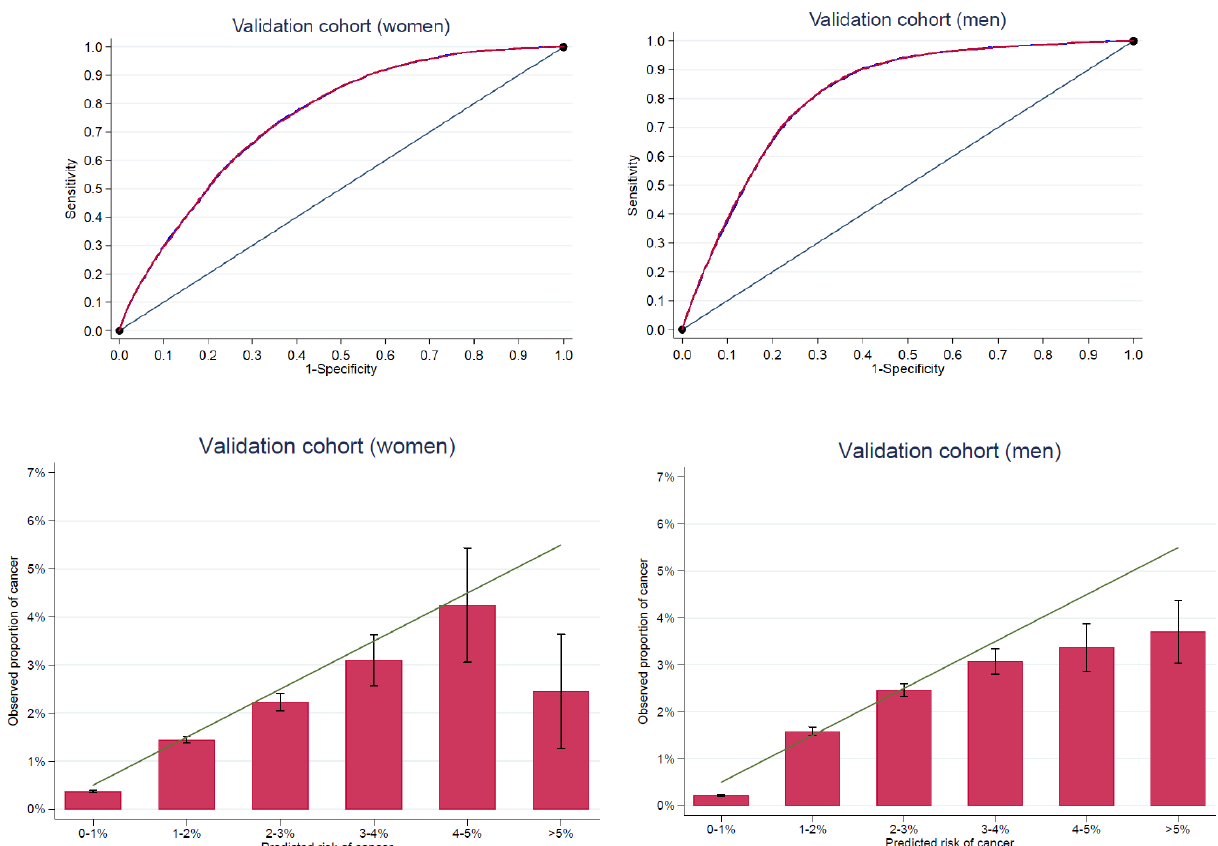
Figure 2. ROC curves in the validation cohort with cancer as the outcome for the CRAM model. Model A (blue) and Model B (red) are almost indistinguishable ( upper figures ). Predicted versus observed cancer cases with 95% confidence bars ( lower figures ). Table 4. Comparison of AUCs obtained for different prediction models.